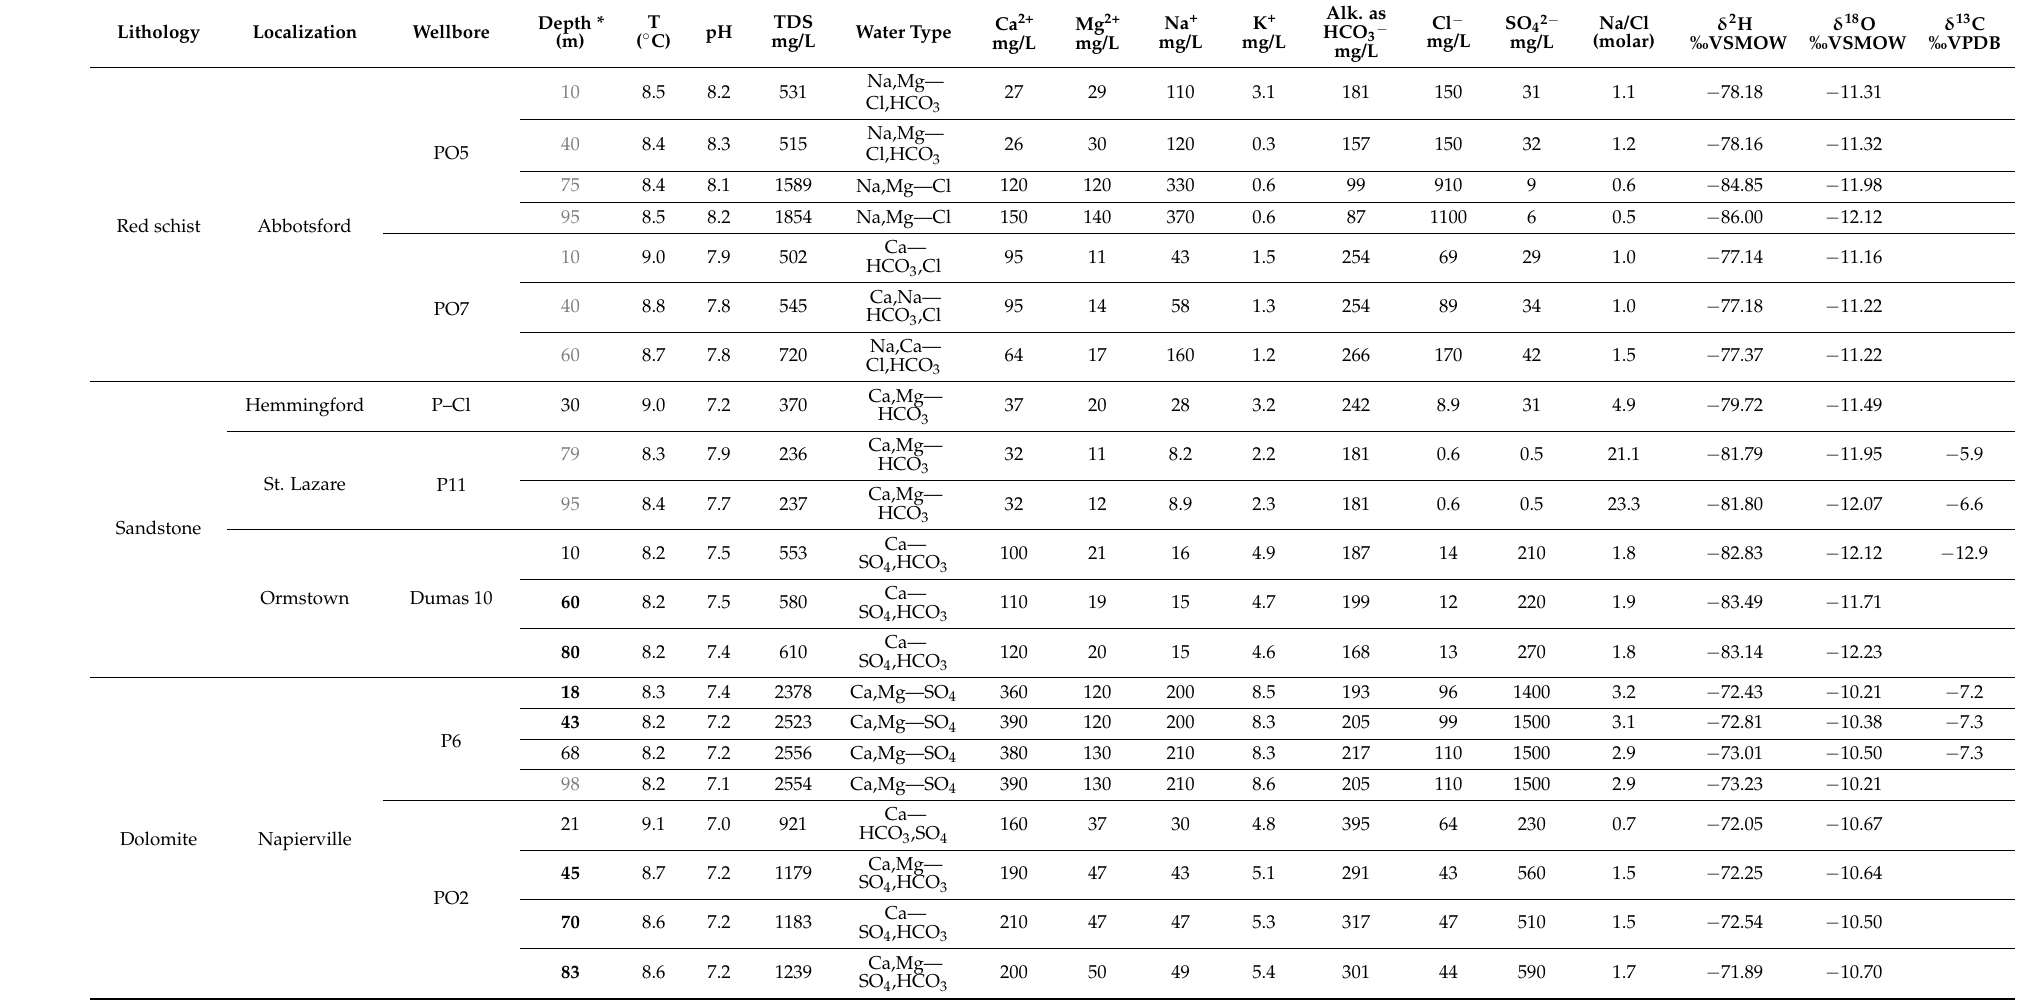
Table 1. Hydrogeochemical data gathered from passive